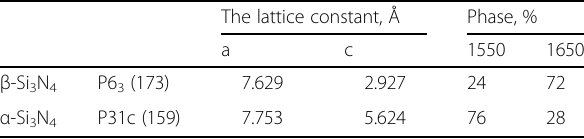
Table 4 XRD and characteristics of the obtained